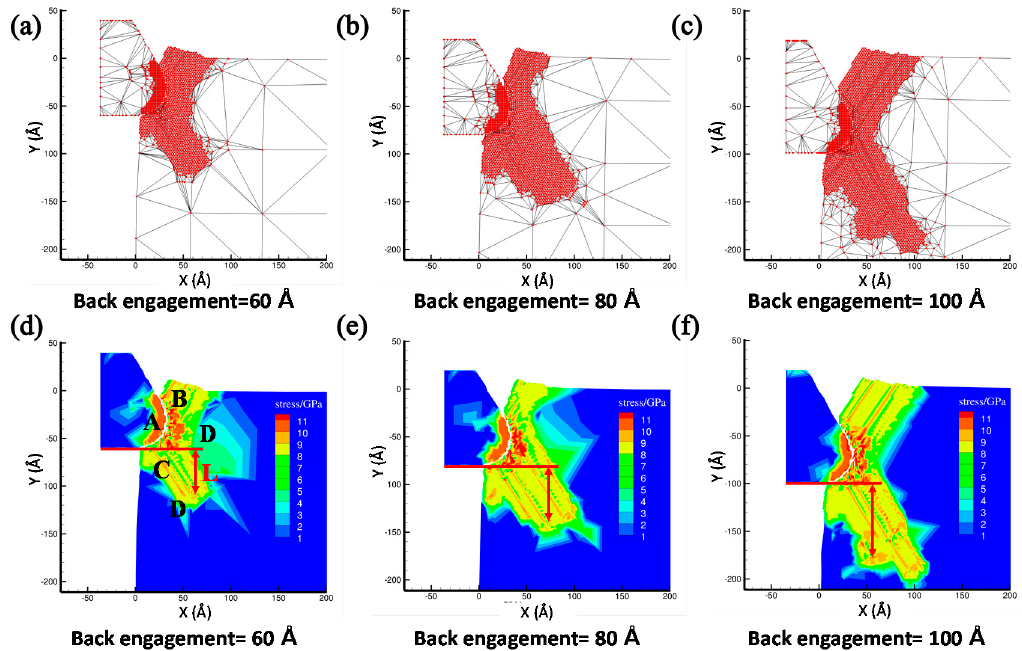
Figure 3. The atomic displacement and corresponding stress distribution at the 200th step with varying the back-engagement from 60 to 100 Å. ( a ) The atomic displacement when back-engagement = 60 Å; ( b ) the atomic displacement when back-engagement = 80 Å; ( c ) the atomic displacement when back-engagement = 100 Å; ( d ) the corresponding stress distribution when back-engagement = 60 Å; ( e ) the corresponding stress distribution when back-engagement = 80 Å and ( f ) the corresponding stress distribution when back-engagement = 100 Å.